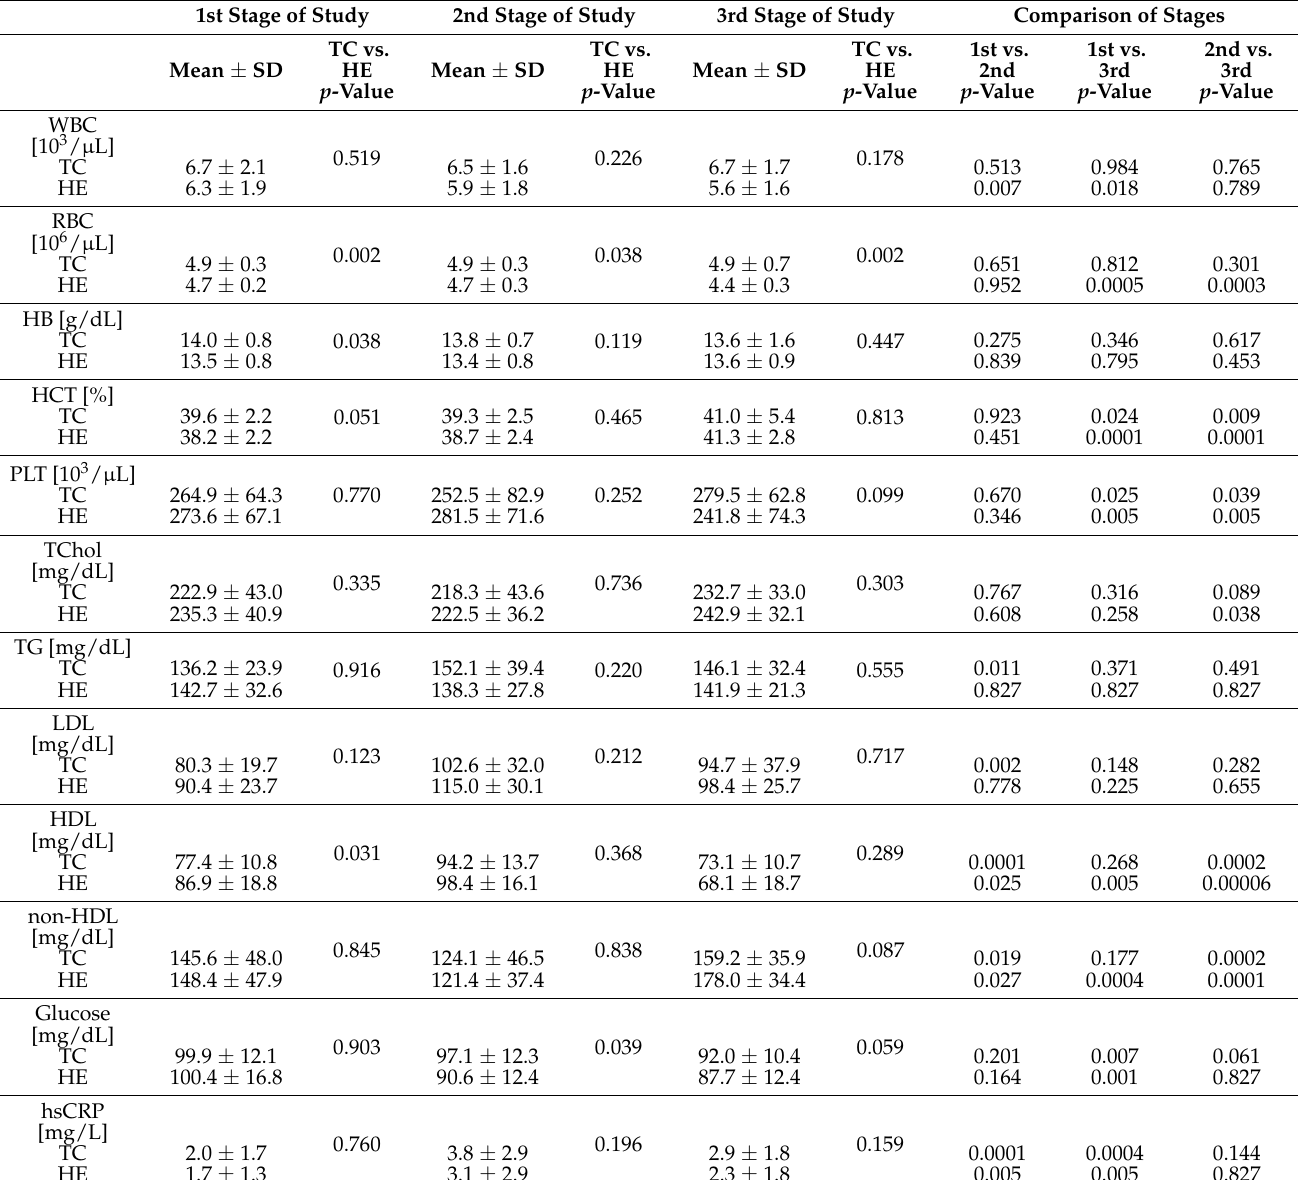
Table 5. Hematological variables, lipoprotein-lipid profile, glucose and C-reactive protein